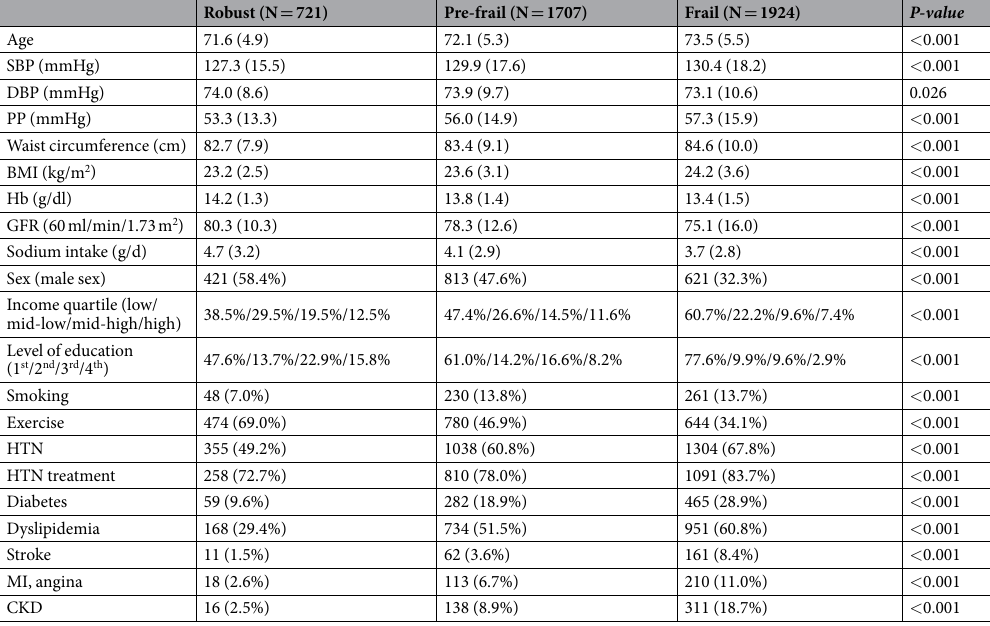
Table 1. General characteristics of the study population according to frailty status (robust, pre-frail, frail). SBP: systolic blood pressure, DBP: diastolic blood pressure, PP: pulse pressure, BMI: body mass index, Hb: hemoglobin, GFR: glomerular filtration rate, HTN: hypertension, MI: myocardial infarction, CKD: chronic kidney disease. Income quartile: household income/month, Low: household income/month < 650 US dollars, Mid-low: 650 US dollars ≤ household income/month < 1300 US dollars, Mid-high: 1300 US Level of education: 1 st : elementary school or lower, 2 nd : middle school, 3 rd : high school, 4 th : college